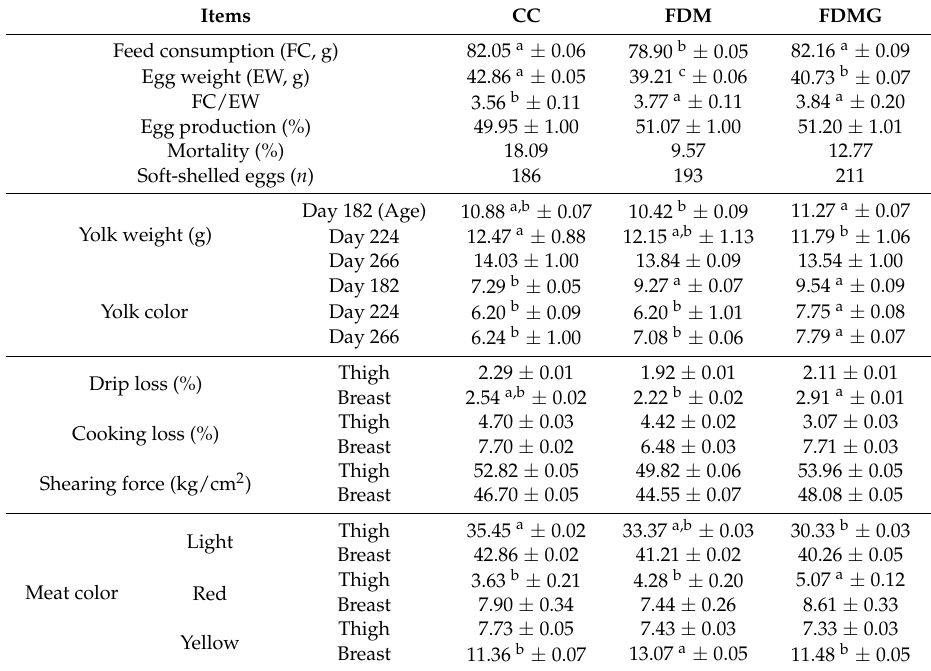
Table 1. Production performance ( n = 100), egg production and quality ( n = 30) and meat quality ( n = 10) among conventional cage feeding (CC), free dietary choice of mealworms feeding (FDM), and free dietary choice of mealworms and grass feeding